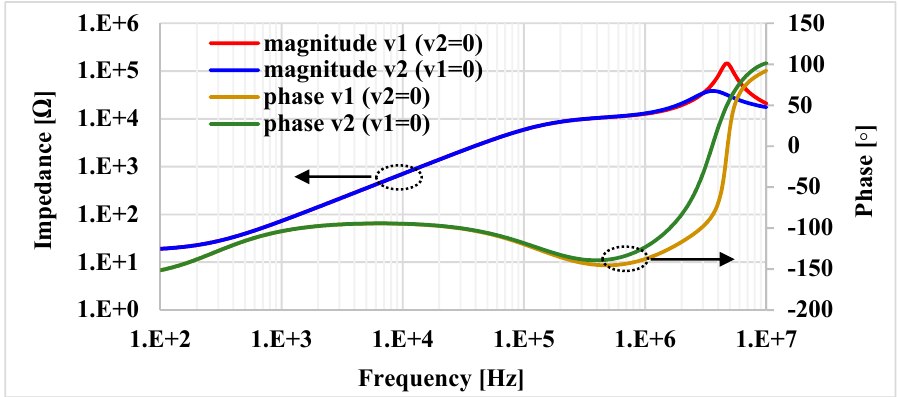
Figure 22. The frequency responses of the series L-R connection with different R set .